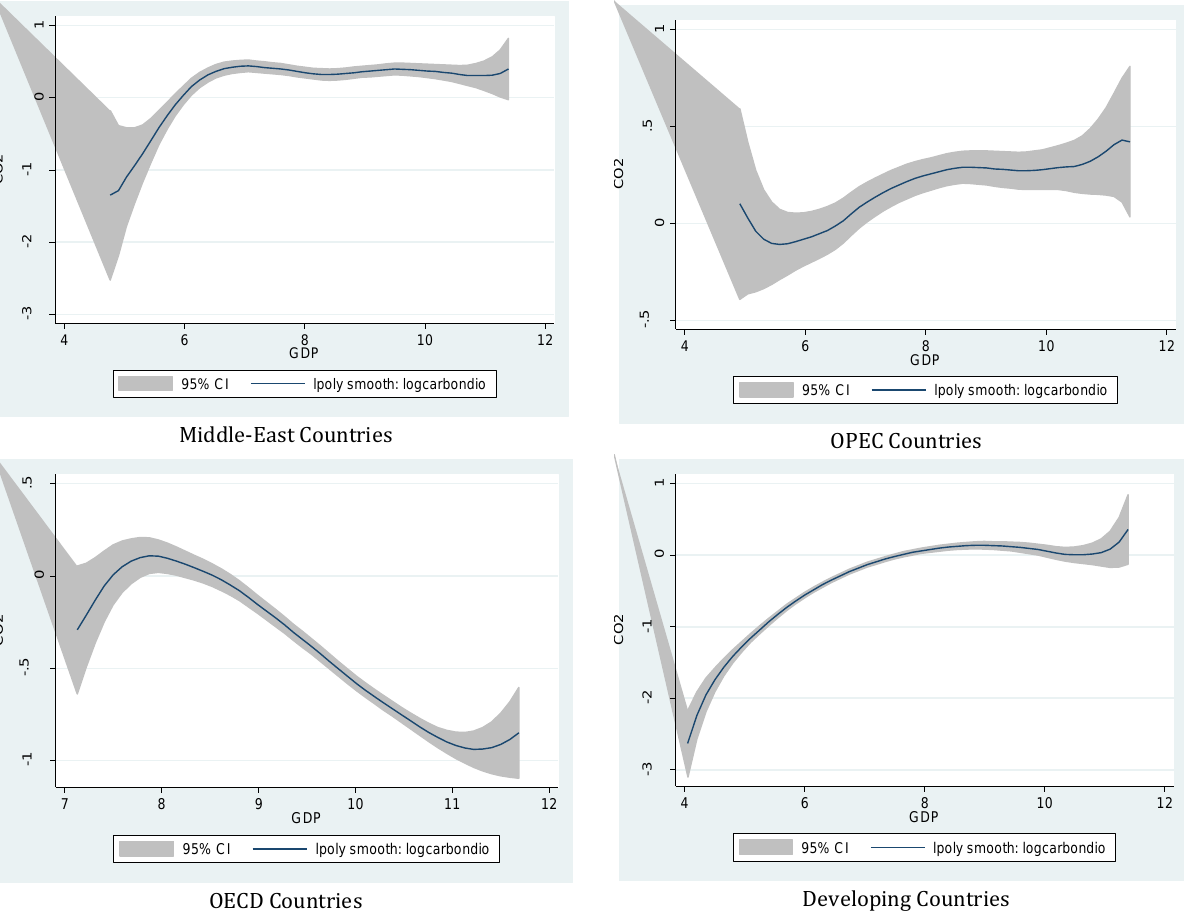
Fig. 1. Shapes of the relationship between Income and CO